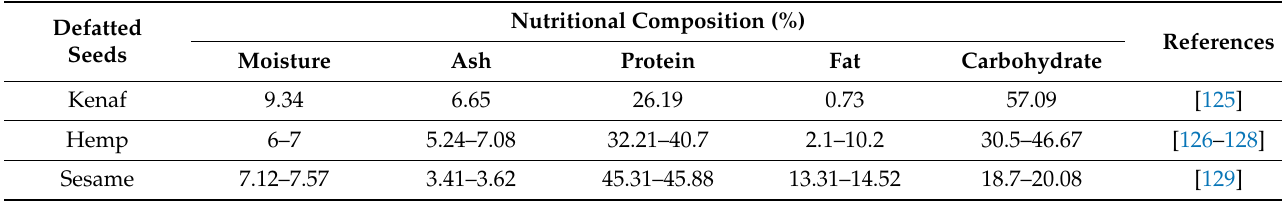
Table 4. Nutritional composition of defatted